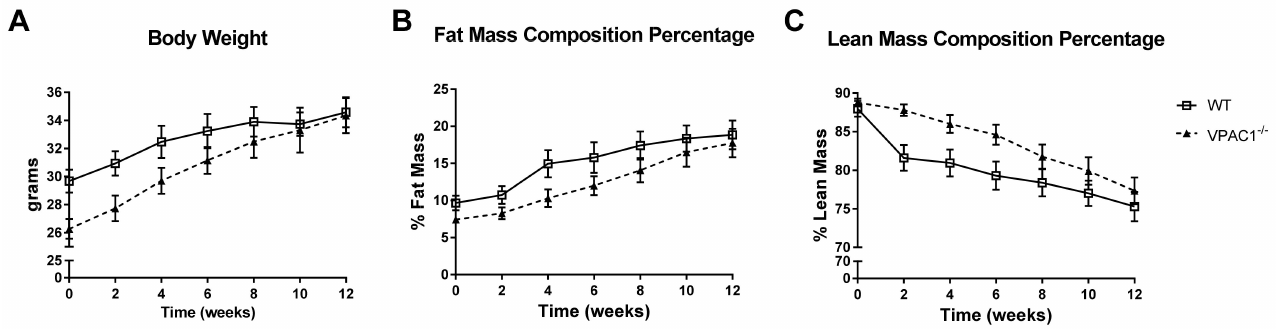
Figure 1. A 12-week analysis of body weight (g) ( A ), fat mass % ( B ), and lean mass % ( C ) was conducted in VPAC1 − / − (closed triangle) and WT mice (open square). Unpaired t -test was used for the data analysis; Values are means ± SEMs.